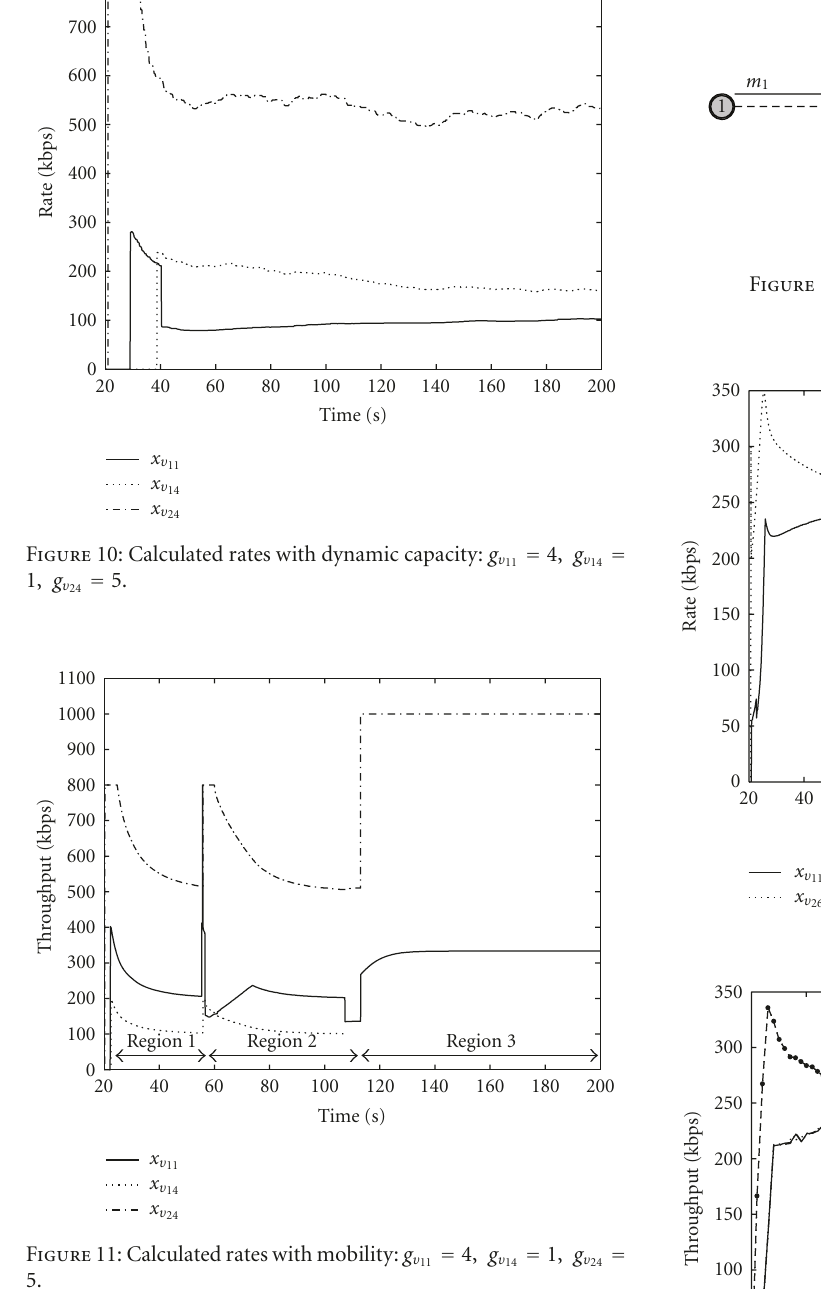
Figure 11: Calculated rates with mobility: g υ 5.